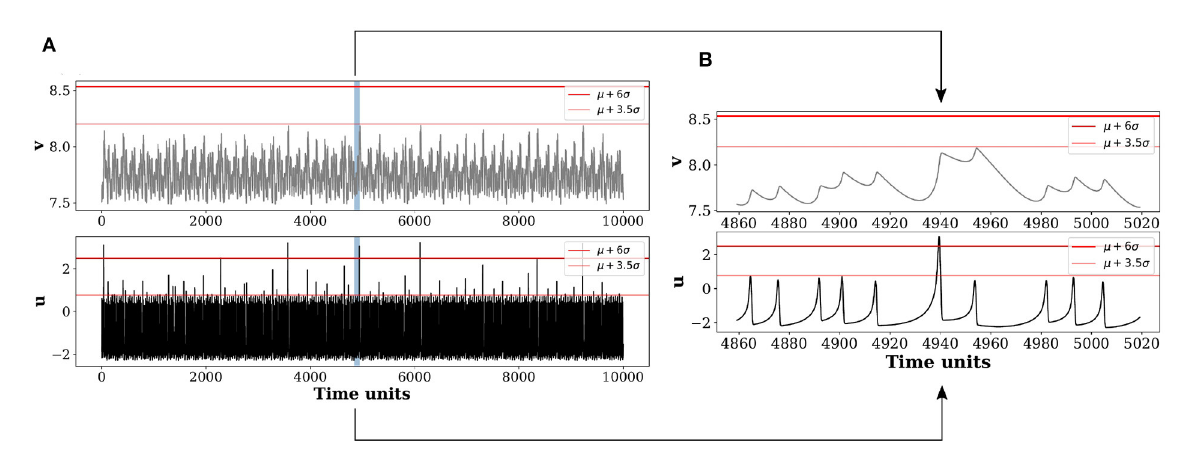
FIGURE1 Time series of slow variable v and fast variable u of the coupled Hindmarsh-Rose (HR) system. (A) Horizontal red lines in the time series of u = h µ i + 3.5 σ (thin line), H s = h µ i + 6 σ (bold line); µ and σ are the mean (lower panel) and v (upper panel), indicate two threshold heights H s 1 2 and standard deviation of the time series, respectively. Threshold height H s filters out many large peaks that are otherwise qualified as extremes 2 by the lower threshold H s , and thereby allows a selection of rarer extreme events only. One particular extreme peak (shaded region) is marked 1 in (A) as shown in u , and zoomed in the lower panel of (B) for illustration. This extreme peak is larger than both the horizontal lines H s and H s 1 2 so as to qualify as a rare extreme event. The corresponding part of the time series of the slow variable v in the upper panel of (A) that never crosses either of the thresholds, H s and H s , is zoomed in and shown in the upper panel of (B) . Although a slight increase in size of the peak is 1 2 seen (B) compared to its neighboring peaks (upper panel), there is not much significant change in height in comparison to the extreme peak observed in u in the lower